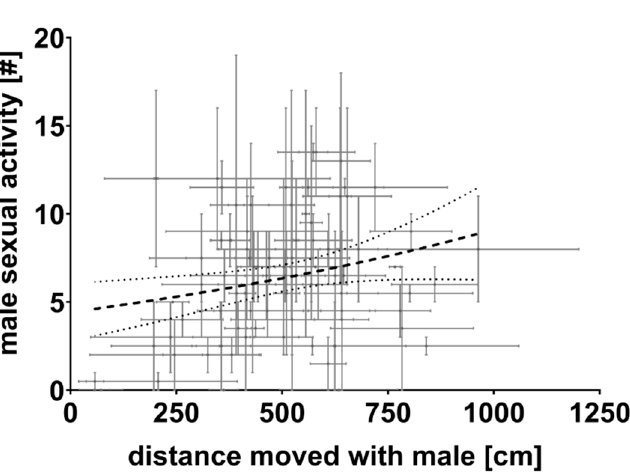
Figure 3. Male sexual activity (sum of courtship displays and copulation attempts) and female swimming activity (distance moved in an open field tank with a male partner). The regression line refers to the final generalized linear mixed model (GLMM) predictions (with 95% CI). Error bars represent SD.